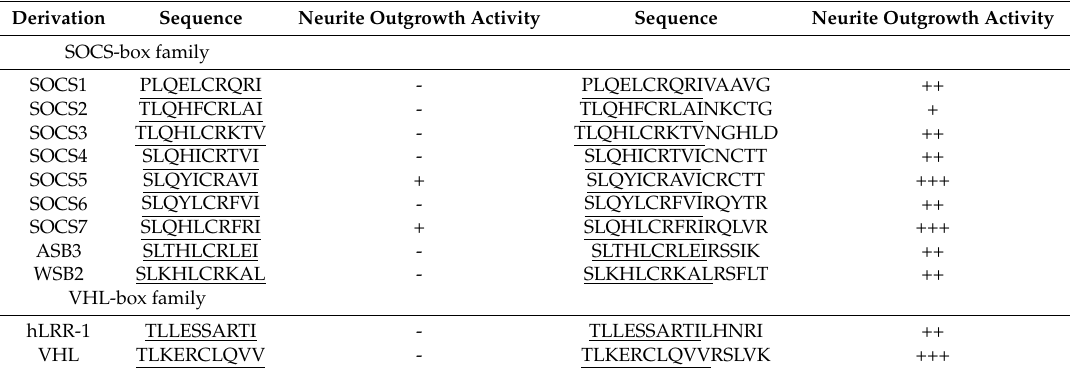
Table 3. Neurite outgrowth activity of cells after BC-box protein-derived peptide